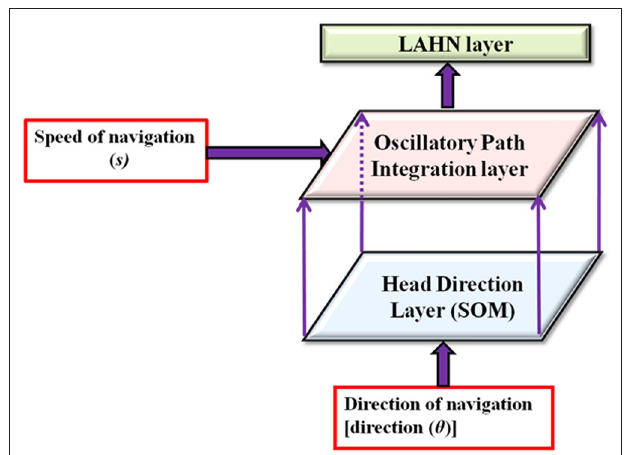
FIGURE 1 | Model architecture. Model receives the velocity information as input and passes through a hierarchy of processing stages such as head direction layer, path integration layer and lateral anti hebbian network (LAHN). Arrows show the direction of flow of information from one hierarchy to the next.